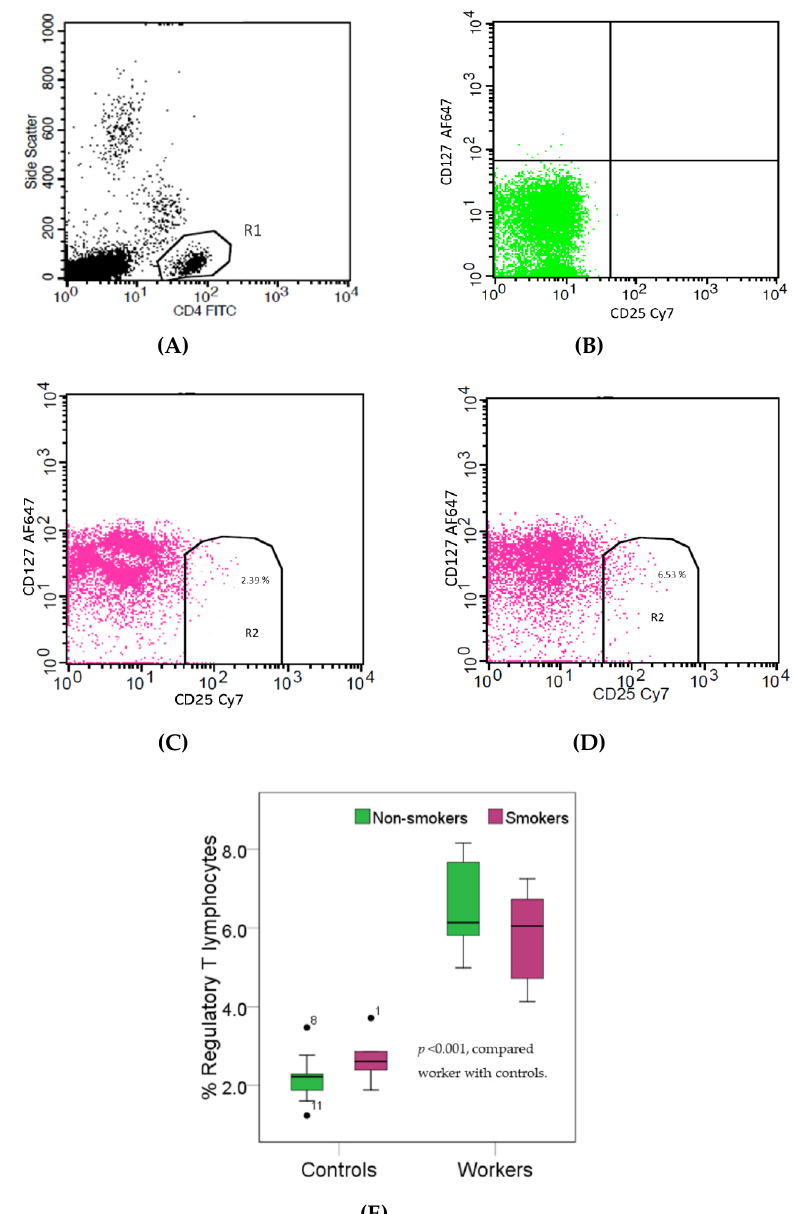
Figure 3. Effects of high Pb exposure on the percentage of regulatory T lymphocytes. The flow cytometry strategies (dot plots) show side scatter vs. CD4 (FITC) ( A ), isotype control stained (B), the regulatory T (Treg) lymphocytes in one control subject ( C ) and one Pb-exposed worker ( D ). Boxplots compare percentages of regulatory Treg lymphocytes in controls versus workers, non-smokers, and smokers included ( E ). Outliers were the data points below or above 1.5× interquartile range. The p -value was derived from the Mann–Whitney U test, in which outliers were included.